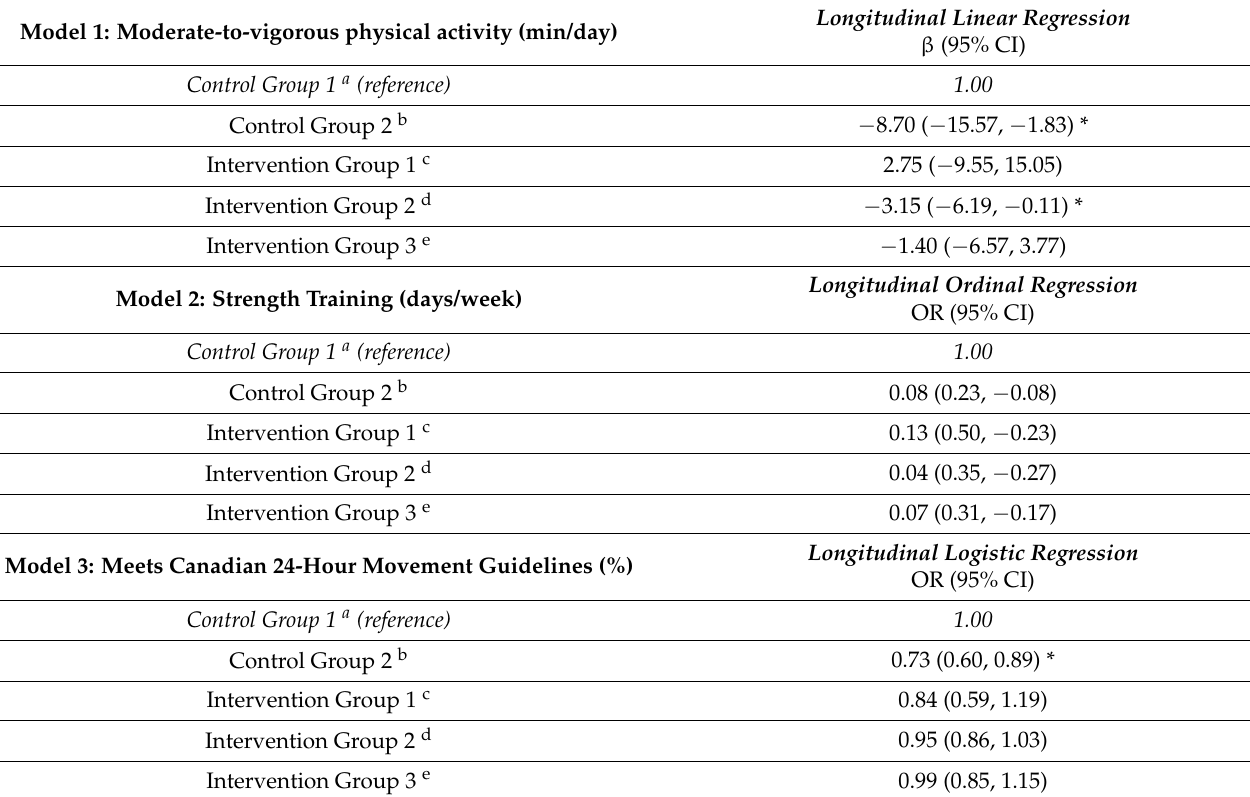
Table 3. Evaluating the impact of the Healthy Kids Community Challenge (HKCC) on moderate-to-vigorous physical activity (MVPA), strength training, and meeting the Canadian 24-Hour movement Guidelines from Time 1 (2014–2015) to Time 3 (2016–2017) in the longitudinal sample of students in the COMPASS